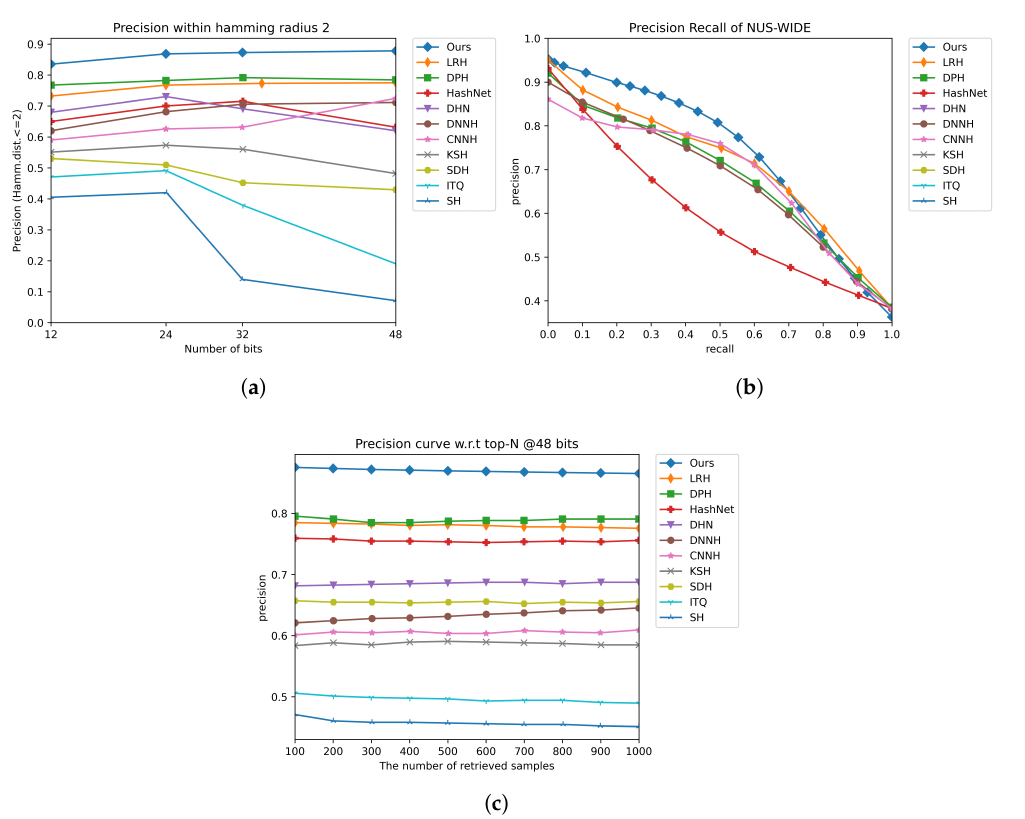
Figure 3. The comparison results on the NUS-WIDE dataset under three evaluation metrics. ( a ) Precision within hamming radius 2. ( b ) Precision Recall Curve on 48 bits. ( c ) Precision curve w.r.t top-N @48